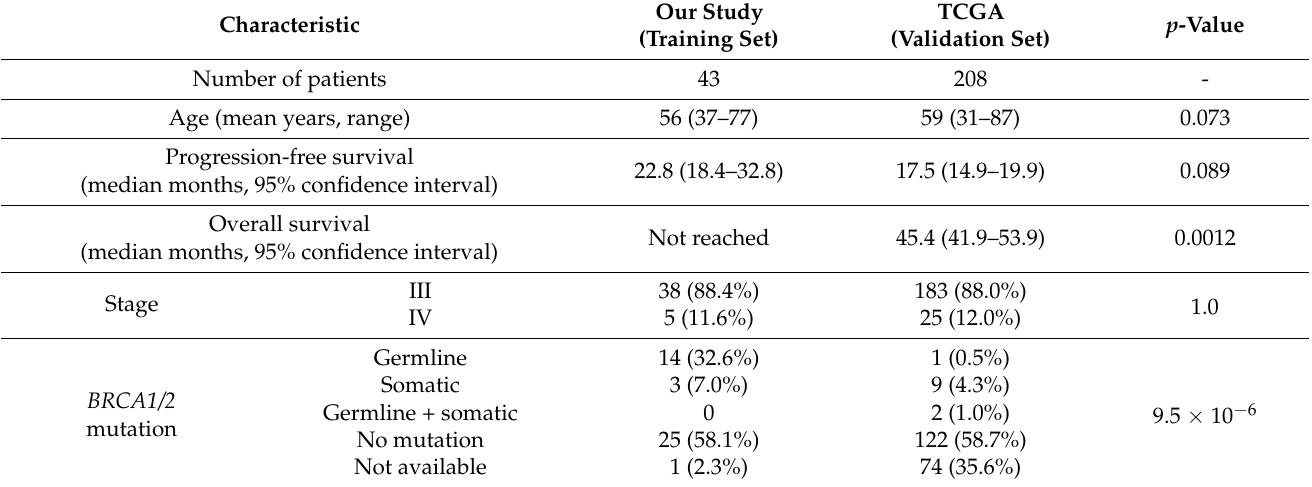
Table 2. Clinical characteristics of patients in the training set and validation set for predicting